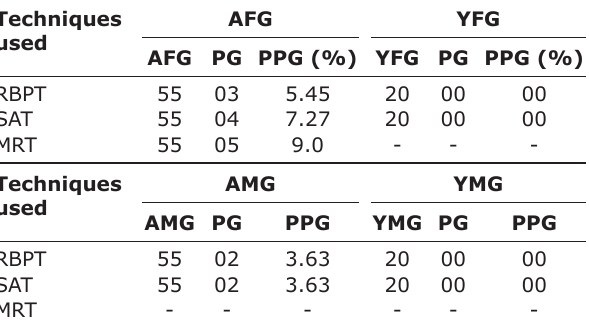
Table-3: Diagnosis of brucellosis in different categories of goats determined by various techniques used during the present investigation.